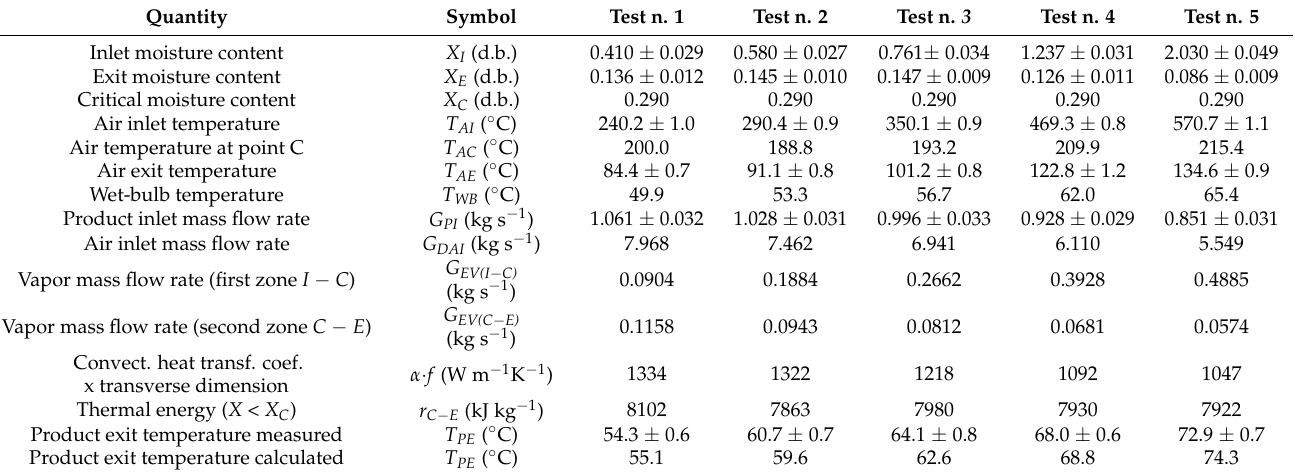
Table 3. Experimental and calculated data from tests described in Section